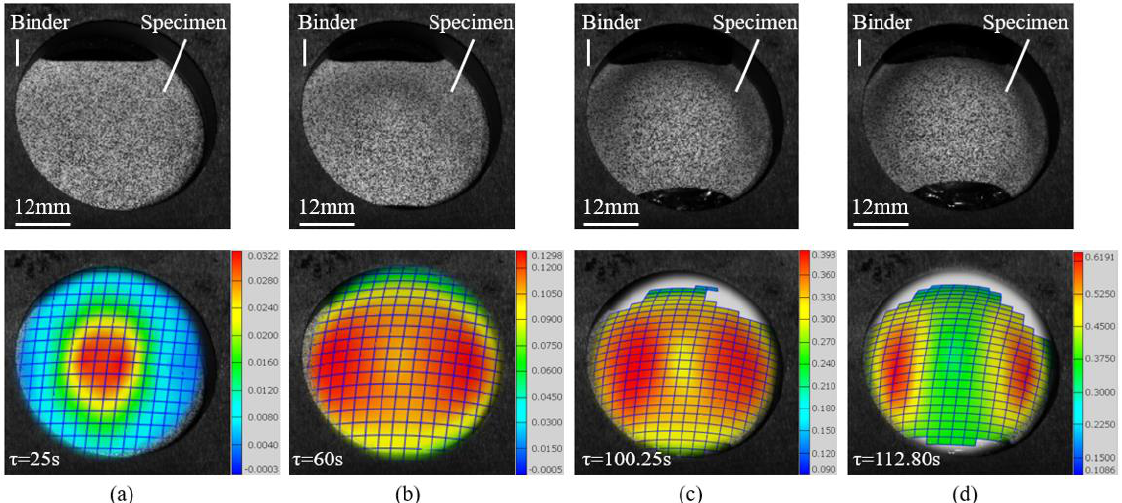
Figure 3. The necking formation in Nakazima tests (the legend denotes the true strain): ( a ) at the beginning of the experiment; ( b ) during the experiment; ( c ) after forming localized necking bands; and ( d ) prior to fracture.